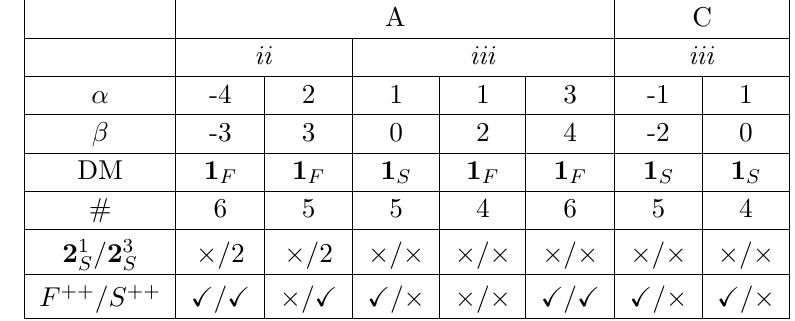
Table 11. The same as in table 10 for Class 2.b of (cid:12)gure 2.